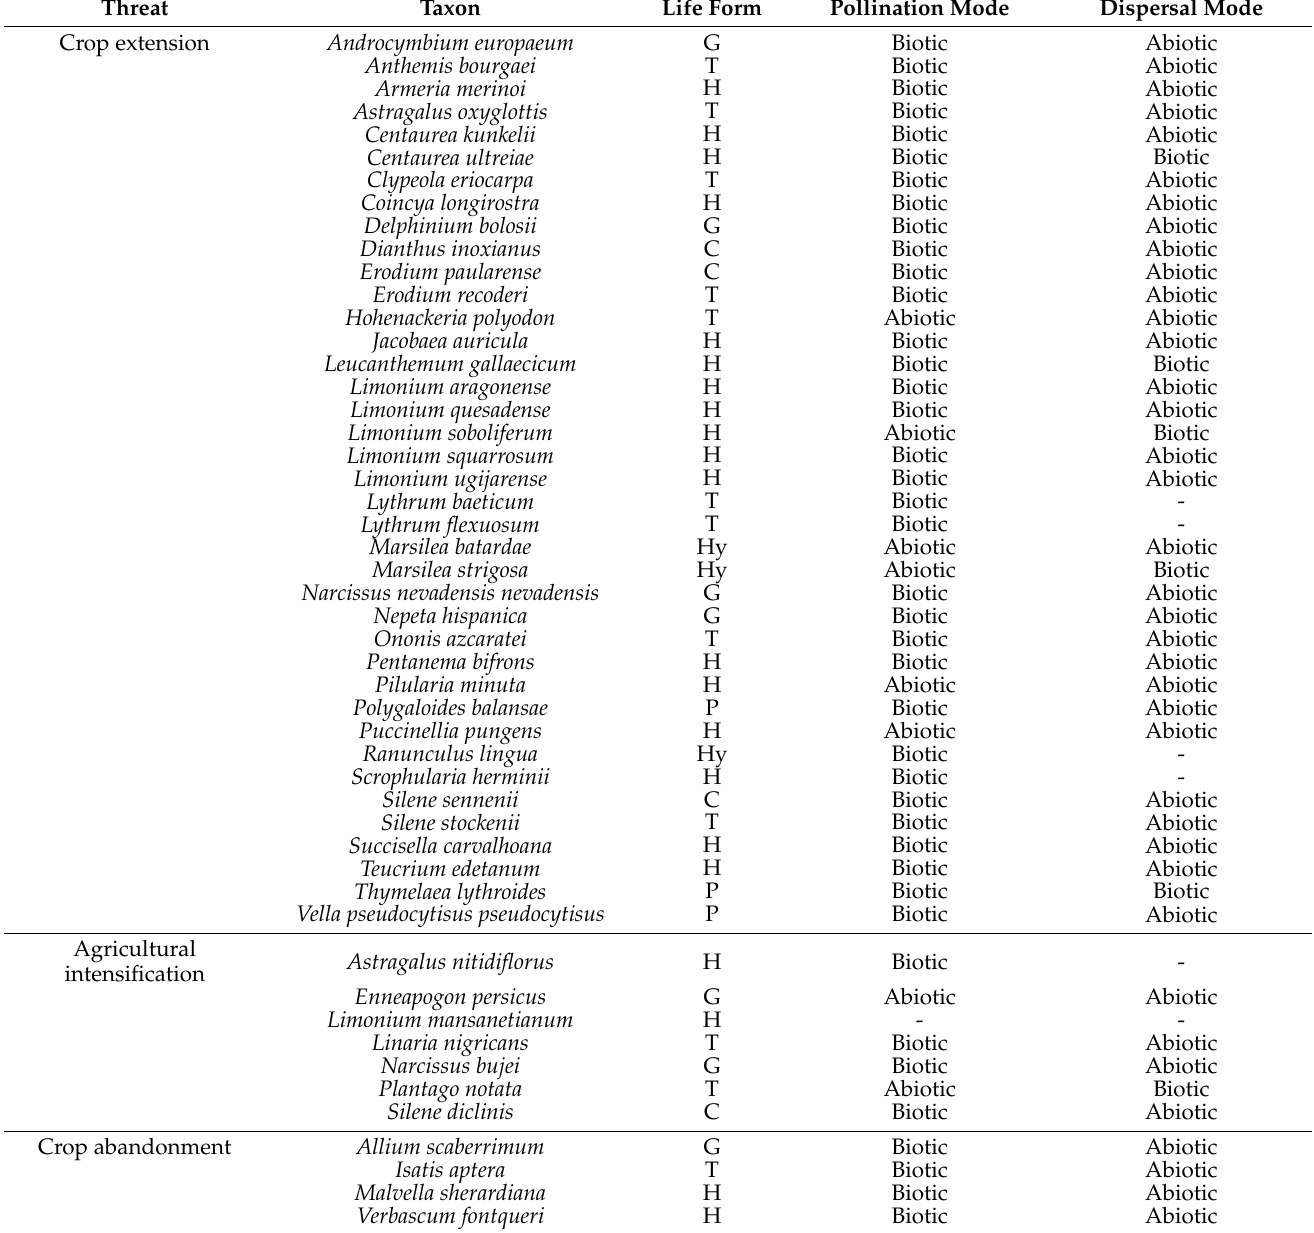
Table 2. Summary of the trial for each of the taxon included in the three threat types (crop extension, crop intensification, and crop abandonment). The trial data included are: life form (C, chamaephytes; G, geophytes; H, hemicryptophytes; Hy, hydrophytes; P, phanerophytes; T, therophytes), pollination (-, unknown; abiotic; biotic) and dispersal mode (-, unknown; abiotic;